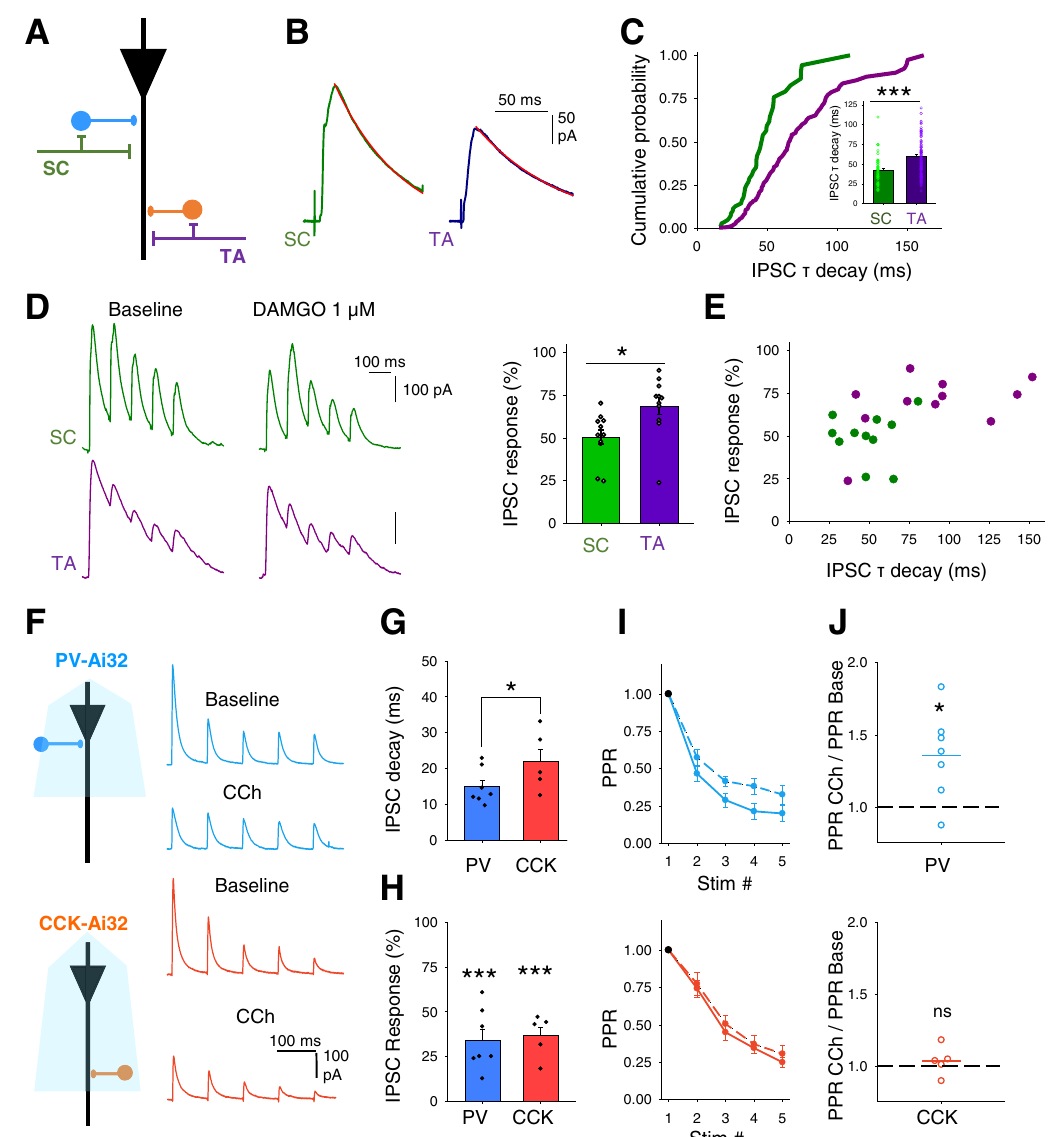
Fig. 3 Cholinergic modulation of inhibitory inputs from distinct feedforward interneuron populations. A Schematic representation of different feedforward interneuron populations engaged by Schaffer collateral (SC) and temporoammonic (TA) pathways within CA1. B , C Disynaptic feedforward IPSCs ( B ) and distribution of decay kinetics ( C ) for Schaffer collateral (SC, green) and temporoammonic (TA, purple) input pathways demonstrating distinct populations of feedforward interneurons. Quanti fi cation of the IPSC tau decay (insert C ) (SC, n = 45 from 24 mice; TA, n = 92 from 36 mice; p = 0.0002). D µ -opioid receptor agonist DAMGO (1 µ M) depression of disynaptic feedforward IPSCs from SC and TA pathways (SC vs TA pathways, n = 11 from 4 mice, p = 0.015). E IPSC decay kinetics and sensitivity to DAMGO correlate and distinguish SC from TA evoked IPSCs. F Optogenetic activation of either PV (top) or CCK (bottom) interneurons at 10 Hz evoked a train of IPSCs in CA1 pyramidal neurons. IPSCs from both interneurons are depressed by CCh (10 µ M). G , H IPSCs from PV interneurons display faster decay kinetics than IPSCs from CCK interneurons ( G PV, n = 7; CCK, n = 5; p = 0.02) but CCh depressed the IPSC amplitudes of the fi rst responses in the train by a similar amount ( H PV, n = 7, p < 0.0001; CCK, n = 5, p < 0.0001). I , J IPSCs from both PV and CCK interneurons demonstrated frequency-dependent depression. Frequency-dependent depression was reduced after CCh application for PV (top; n = 7, p = 0.010) but not CCK (bottom; n = 5; p = 0.172) evoked IPSCs. Data are mean ± SEM; Comparisons are two-tailed paired t -test *** p < 0.001, ** p < 0.01, * p < 0.05. Source data are provided as a Source Data fi le. with this stimulation protocol (Fig. 1) 38,48,49 . To test the the inferred contribution of PV + and CCK + interneurons to SC sensitivity of PV + and CCK + synapses to cholinergic modulation, and TA feedforward pathways and again suggests their periso- CCh was bath applied to the slice whilst selectively evoking either matic and dendritic synaptic locations, respectively. Decay PV + or CCK + derived IPSCs (Fig. 3F). PV + evoked IPSCs kinetics of optogenetically evoked IPSCs were faster than displayed faster decay kinetics to CCK + evoked IPSCs con fi rming disynaptically evoked feedforward IPSCs as predicted for inputs with greater synchrony. CCh depressed IPSCs from both PV + the stimulation of separate interneuron populations (Fig. 3G; PV + decay kinetics, 14.9 ± 1.8 ms, n = 7 vs CCK + decay kinetics, and CCK + synapses indicating a direct cholinergic modulation of 21.9 ± 3.4 ms, n = 5, p < 0.05). The decay kinetics correlate with these interneurons (Fig. 3F, H; PV + responses, 34.3 ± 6.0%, n = 7, NATURE COMMUNICATIONS| (2021) 12:5475